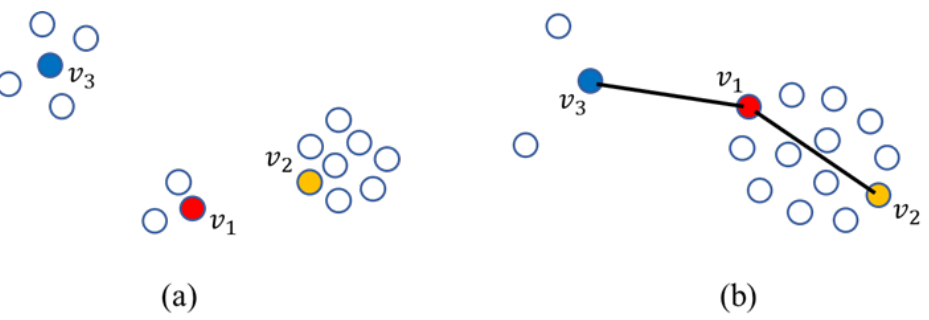
Figure 2. Diagrammatic presentation of comparison between Euclidean distance and similarity distance. ( a ) Three samples are from three different classes; ( b ) Three samples are from two classes. It is natural that if two samples have high similarity, they are likely to come from the same class, even though we know nothing about their exact labels in unsupervised DR problem. That is to say, when two similar samples are mapped to low-dimensional space, they ought to be close to each other according to their similarity in original feature space. Directly using the similarity to represent the distance relationship encounters the problem of non-uniform measurement, so we normalize the similarity by defining the relative similarity r i , j , as